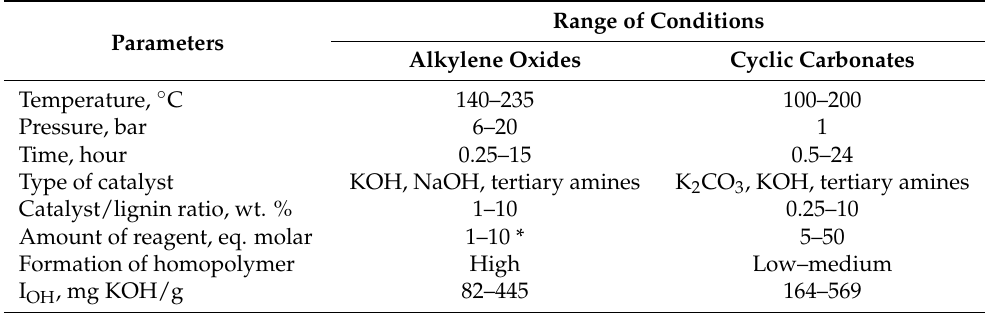
Table 4. Summary of operating conditions and some characteristics of oxyalkylated lignin according to the literature [9,10,15,55,59,65,75]. Range of Conditions Parameters Alkylene Oxides Cyclic Carbonates Temperature, ◦